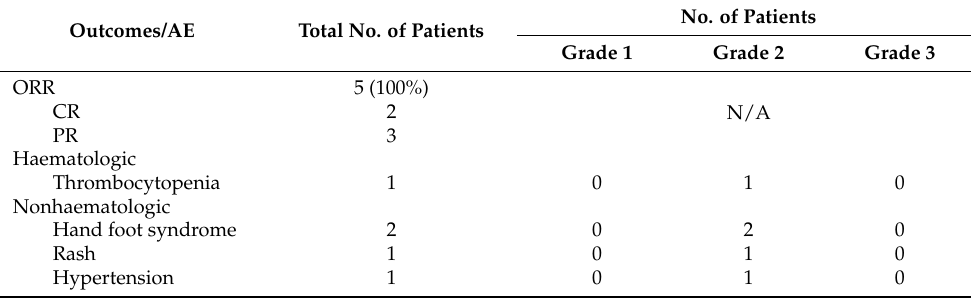
Table 2. Best treatment outcomes and adverse events that occurred in rGBM patients.